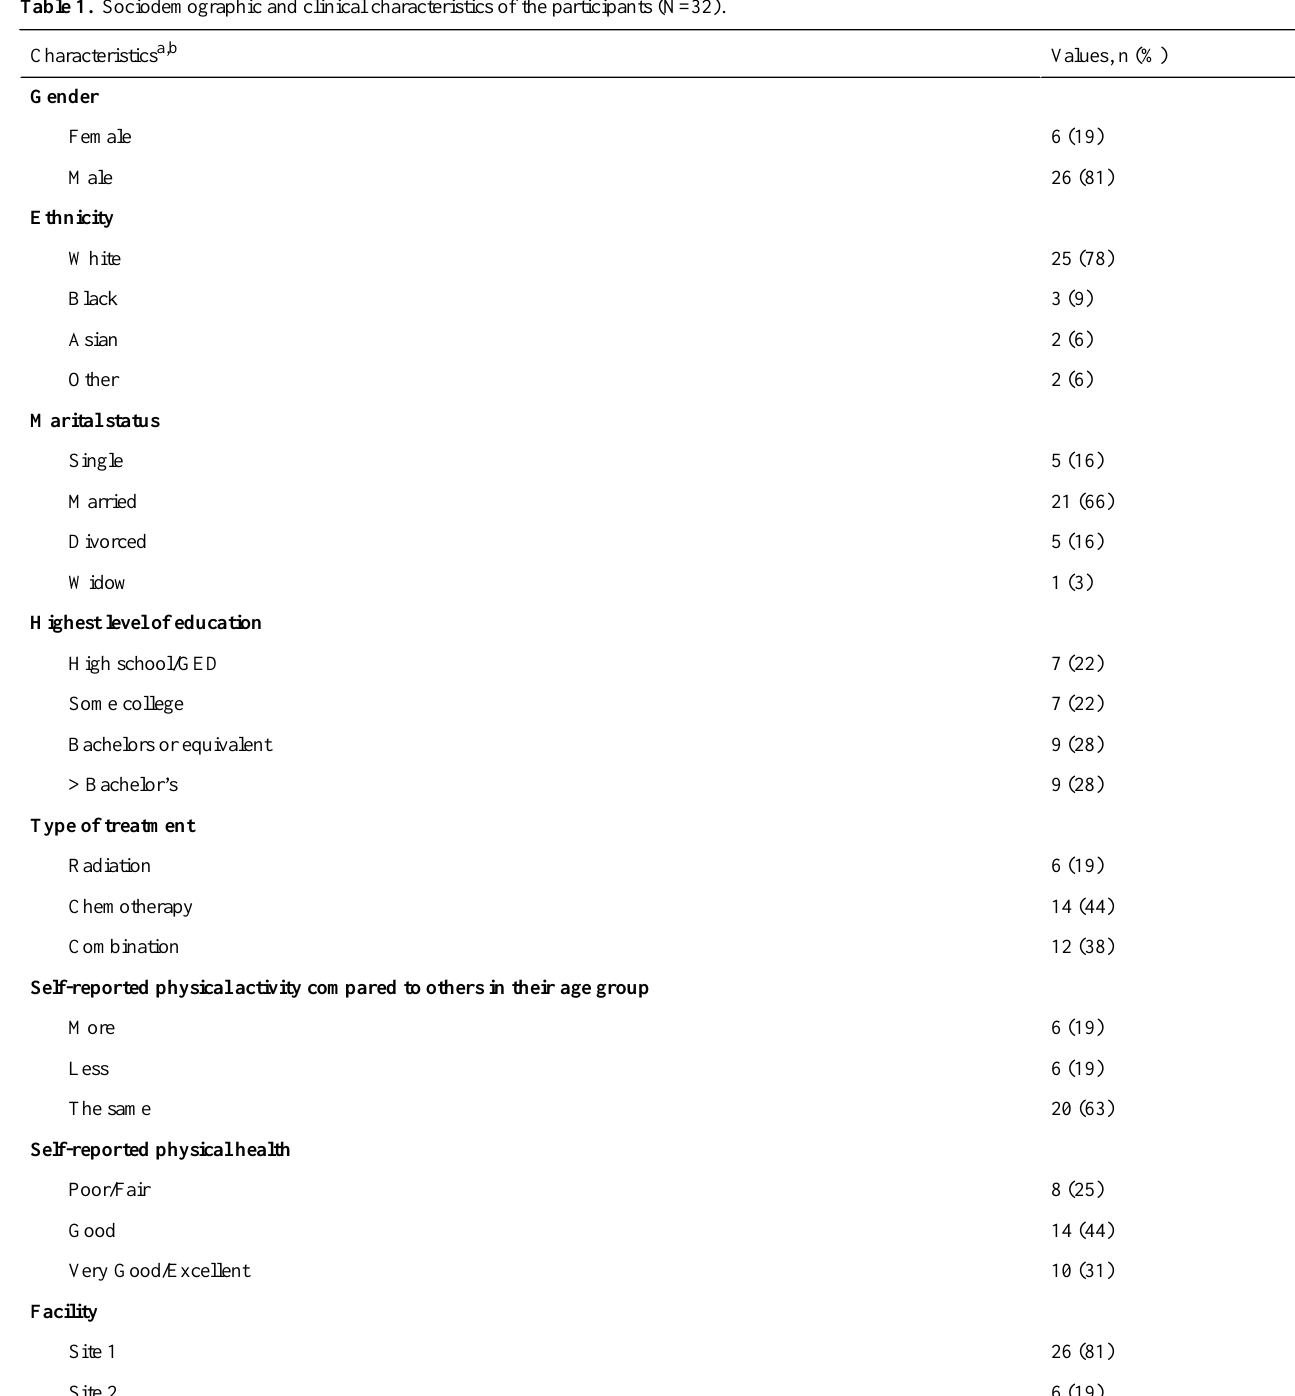
Table 1. Sociodemographic and clinical characteristics of the participants